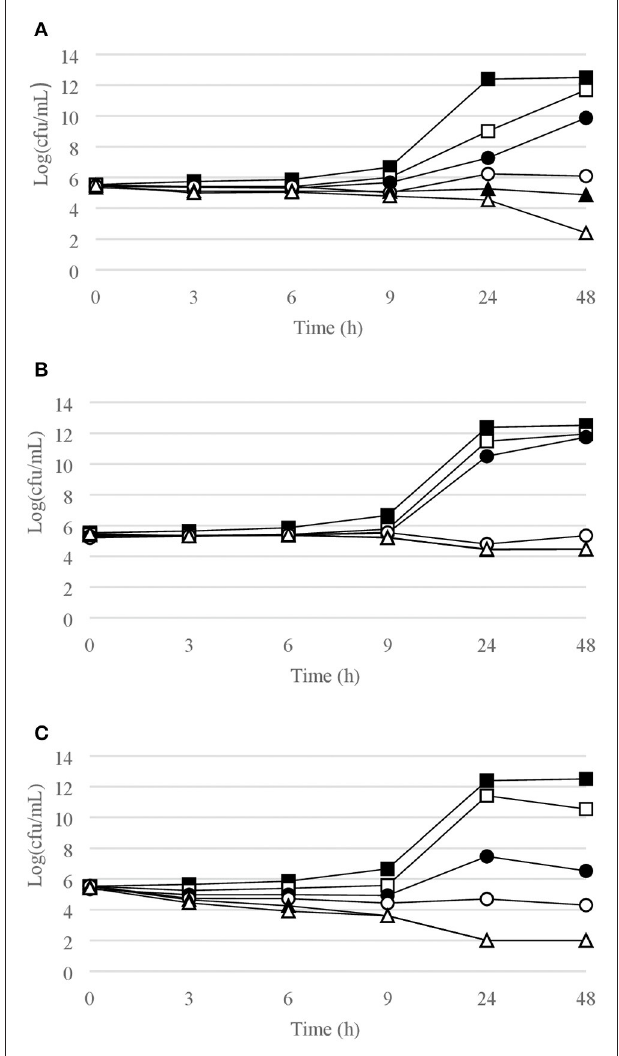
FIGURE 1 | Time-kill curves for S. epidermidis . (A) chlorquinaldol; (B) fusidic acid; (C) gentamicin. Filled square, control; open square, ¼ × MIC; filled circle, ½ × MIC; open circle, 1 × MIC; filled triangle, 2 × MIC; open triangle, 4 ×